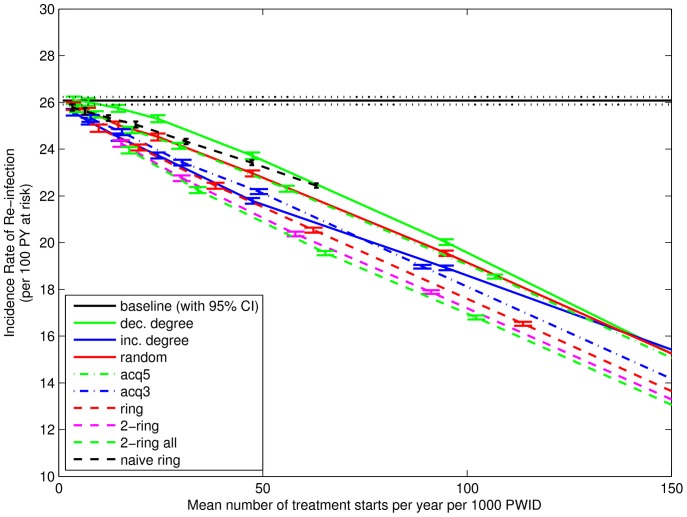
Incidence Rate of Re-infection for Weeks 131–156.Vertical coordinate shows the mean incidence rate of re-infection infection in weeks 131–156, calculated as the mean incidence rates across 500 simulations and then the mean (with 95% confidence interval) across 100 networks. Horizontal coordinate shows the mean number of treatments started in weeks 1–156, calculated as the means across 500 simulations per network, then the mean across 100 networks, and then the mean across 3 years. Strategies that choose nodes at random and ignore the infection status of some (“acq5”) or all (“dec. degree”, “random”) primary contacts have the largest incidence rate of infection. Conversely, the 2-ring strategies have the lowest incidence rate of infection. Mean treatment starts for “naive ring” are smaller because there are limited numbers of infected nodes available for treatment around randomly chosen uninfected nodes.